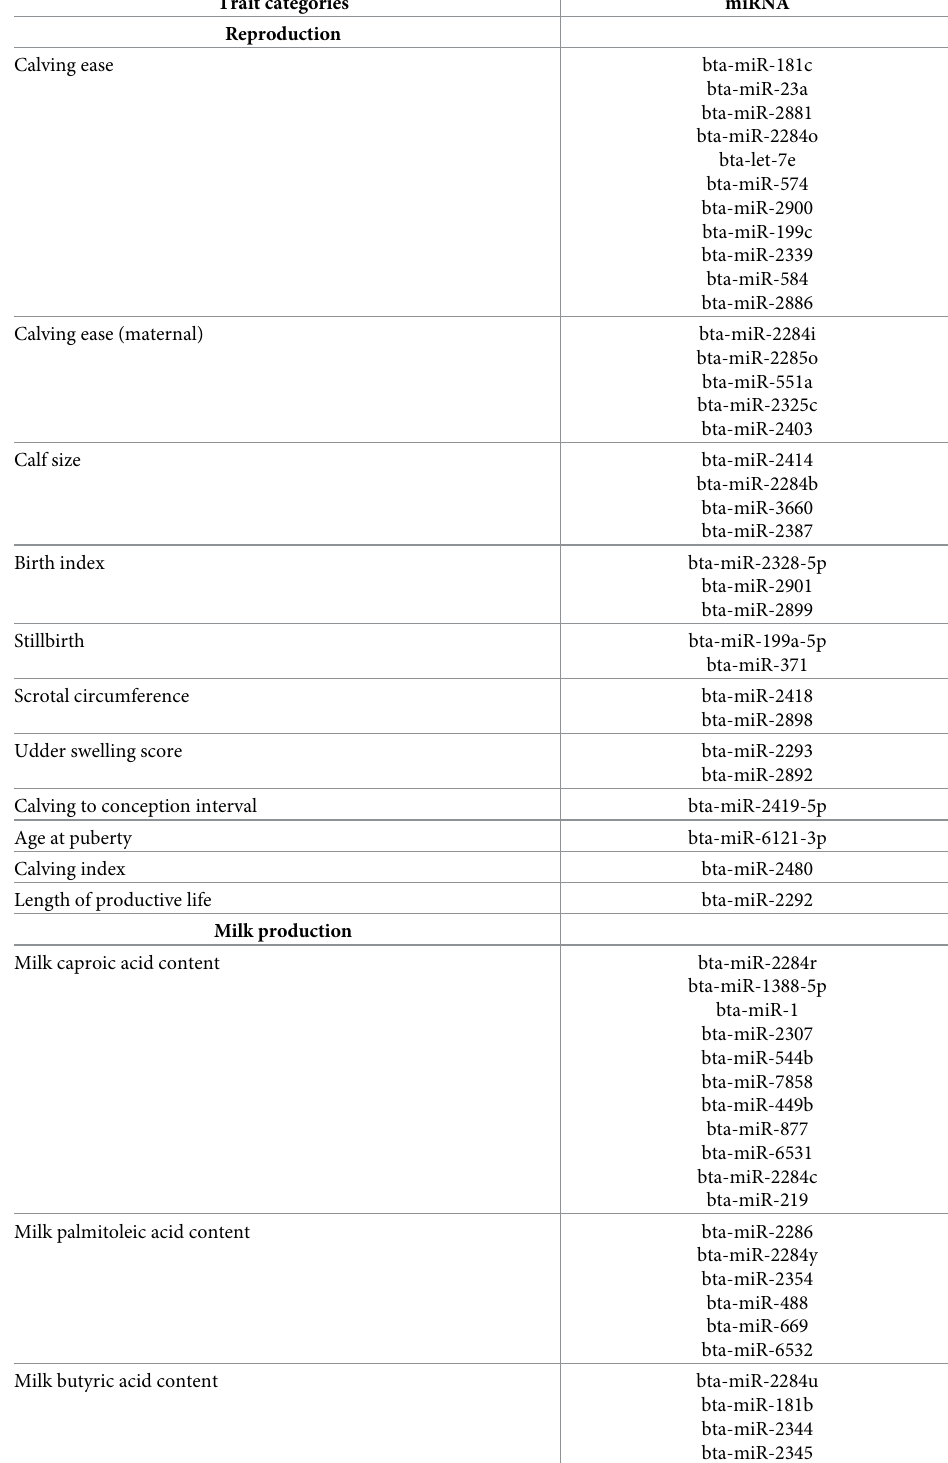
Table 1. Mature miRNA with SNPs affecting target prediction in QTL